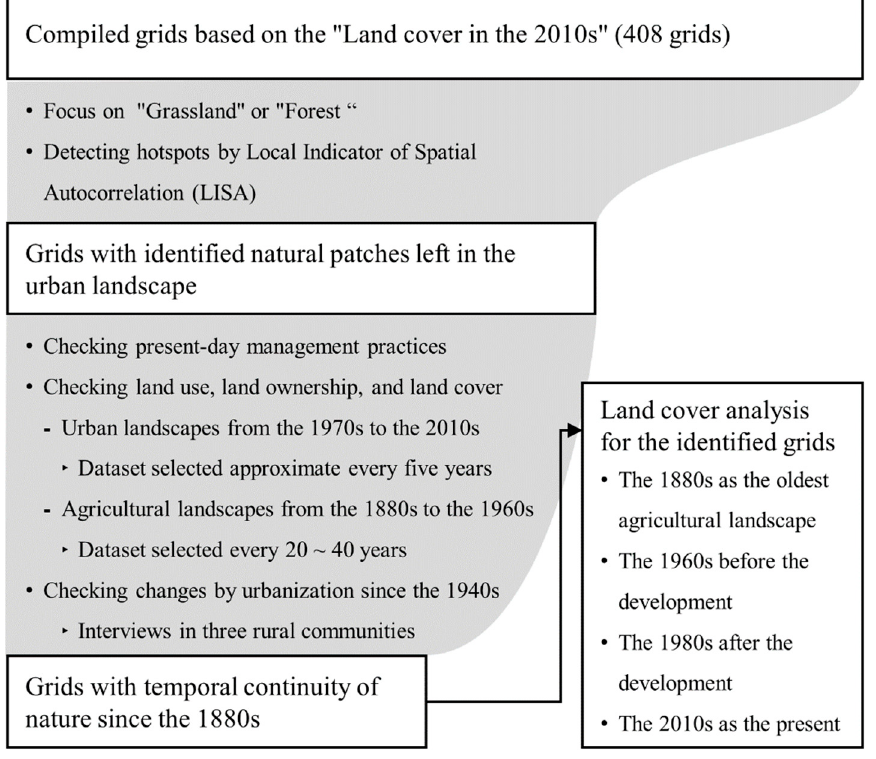
Figure 2. Flow chart of the study’s processes and sources.